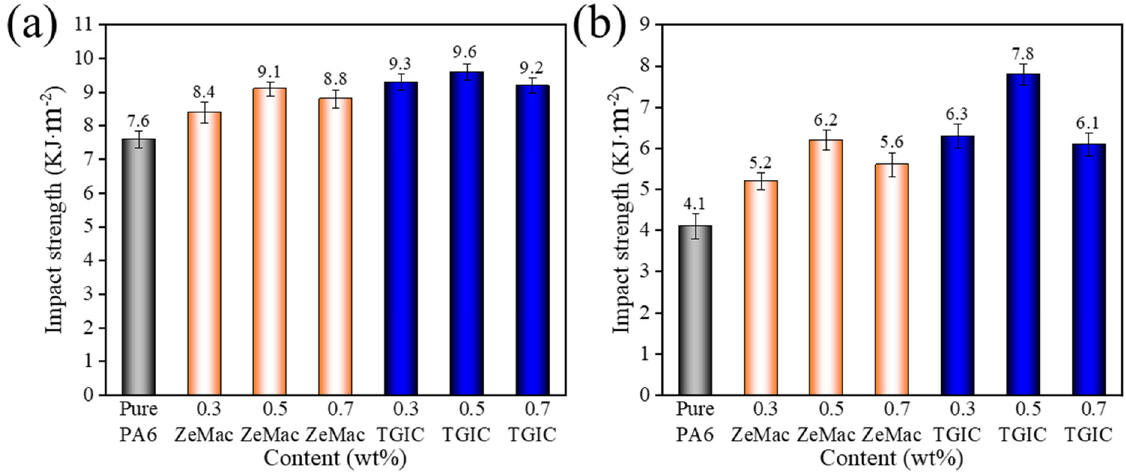
Figure 9: Impact strength of pure PA6 and modi fi ed PA6 foamed samples: ( a ) non - foamed and ( b )